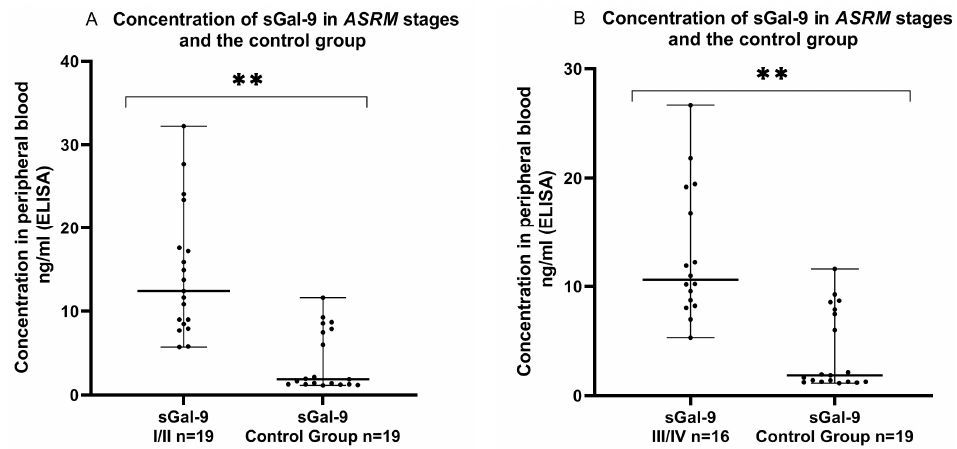
Figure 6. Level of sGal-9 in the plasma in early (I/II) ( A ) and late (III/IV) ( B ) ASRM stages of endometriosis and in the plasma of the control group (ng/mL). The median value with the following sign indicate statistically significant differences: ** p < 0.01.